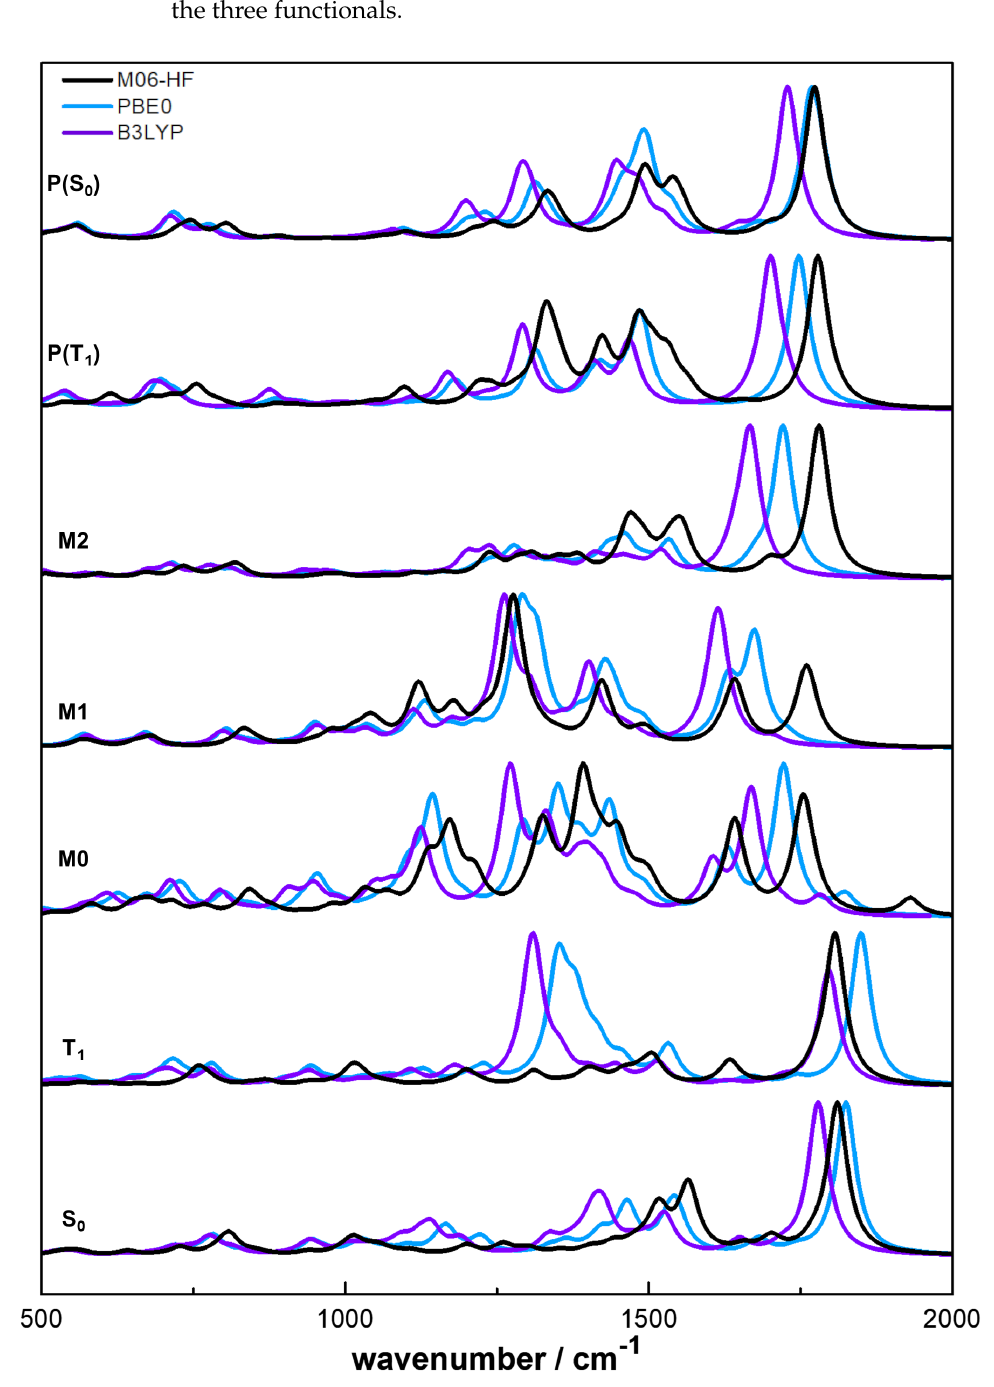
Figure 8. Normalised infrared spectra of the involved species in the photoreaction of